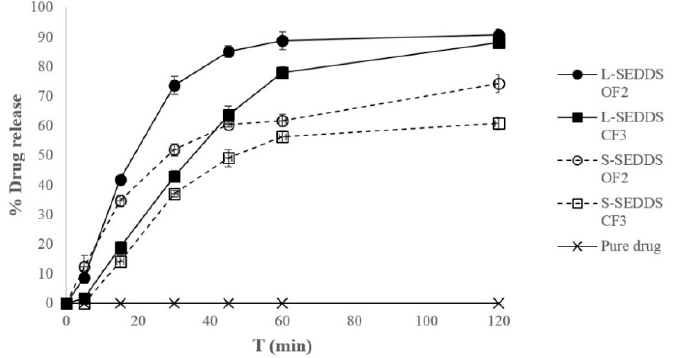
Figure 4. In vitro dissolution profile of ATR from optimized liquid- (L) and solid- (S) SEDDS